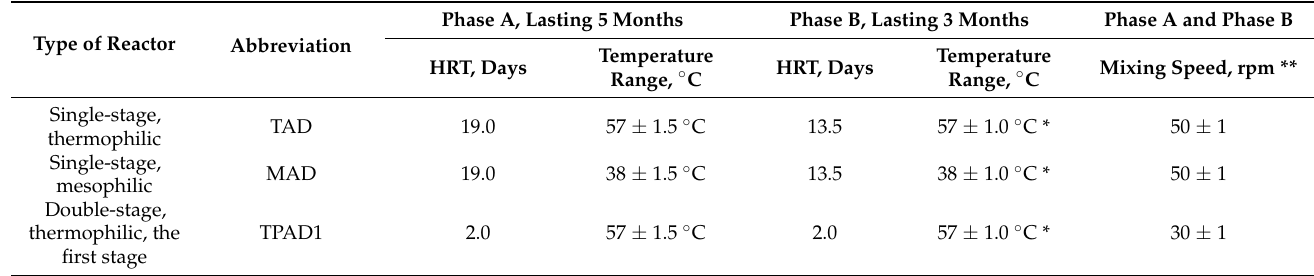
Table 1. Anaerobic digestion operational